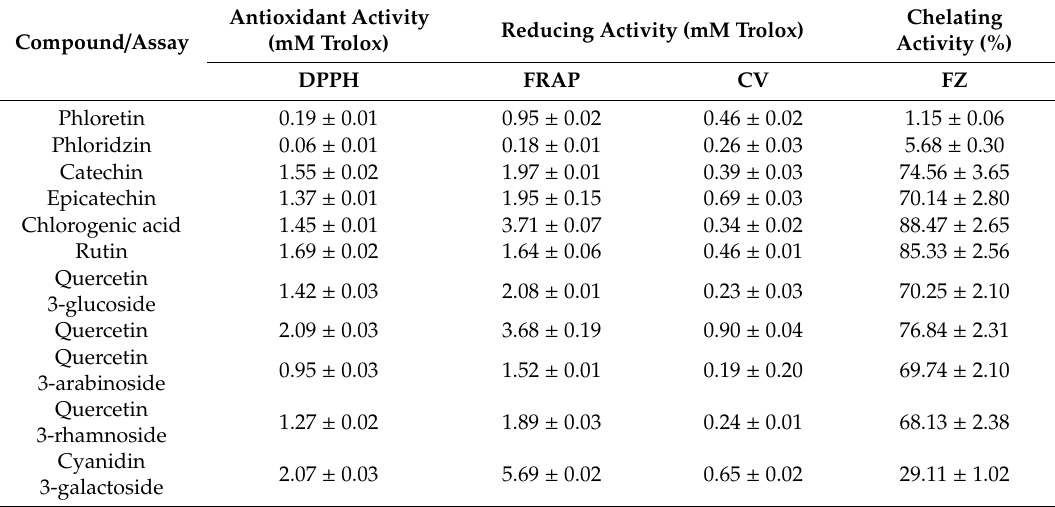
Table 4. Antioxidant, reducing, and chelating activities of phenolic compounds identified in apple peel and flesh by HPLC–DAD–MS / MS.